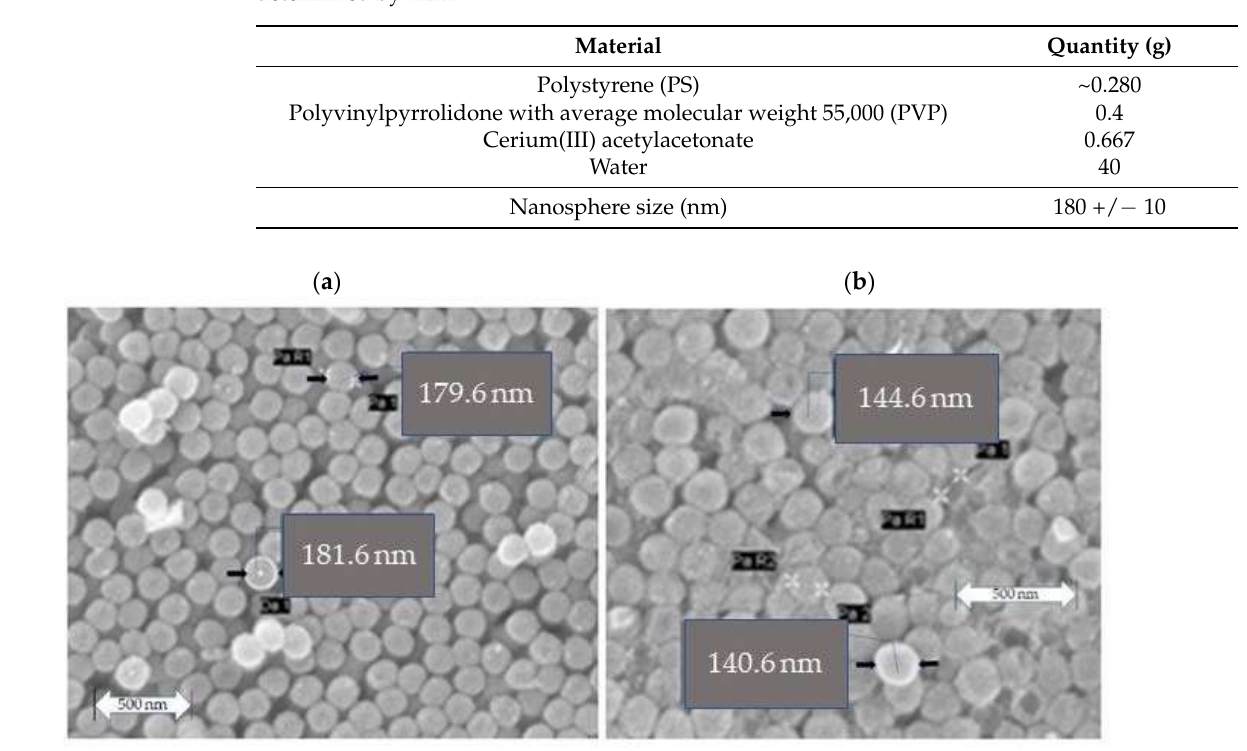
Figure 2. Polystyrene spheres coated with Ce (acac) 3 resulted in a total sphere size of 180 +/− 10 nm ( a ). SEM of CeO 2 nanocontainers after the second heat treatment at 600 °C ( b ).